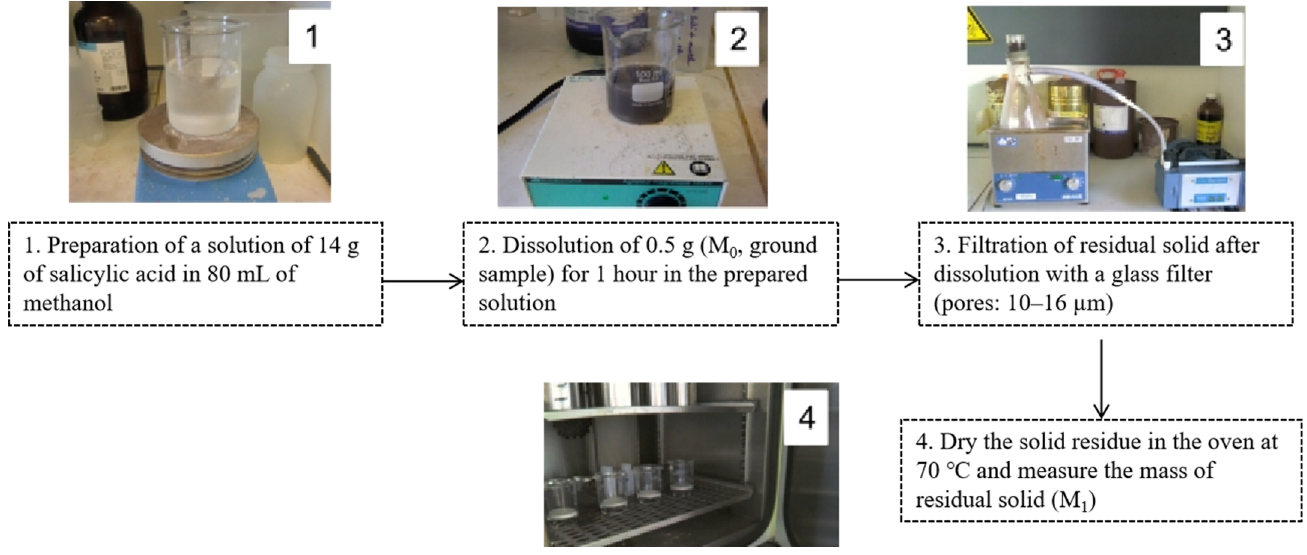
Figure 1. Experimental protocol of measurement of hardened cement paste content in RCA (the subfigure refers to the corresponding procedure).